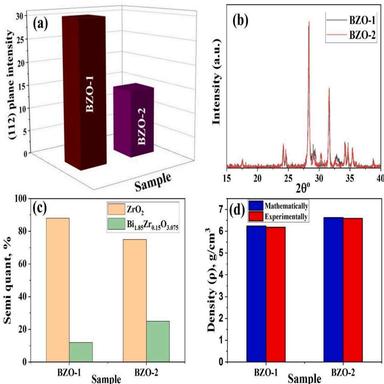
(a) Displays the intensity of the (112) plane in two different BZO composite samples. (b) Shows a magnified portion of the X-ray diffraction pattern ranging from 15◦ to 40◦ of 2θ◦. (c) Compares the percentages of ZrO2 and Bi1.85Zr0.15O3.075 in the two BZO composite samples. (d) Presents the experimentally and mathematically calculated density of the two BZO composite samples.